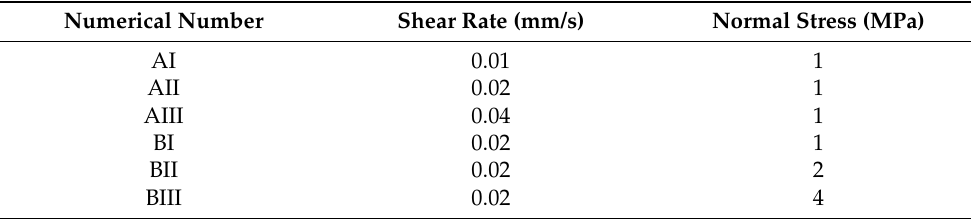
Figure 7. A conceptual model for rock-like materials containing two holes. Table 2. Shear rate and normal stress of six cases in the numerical model.